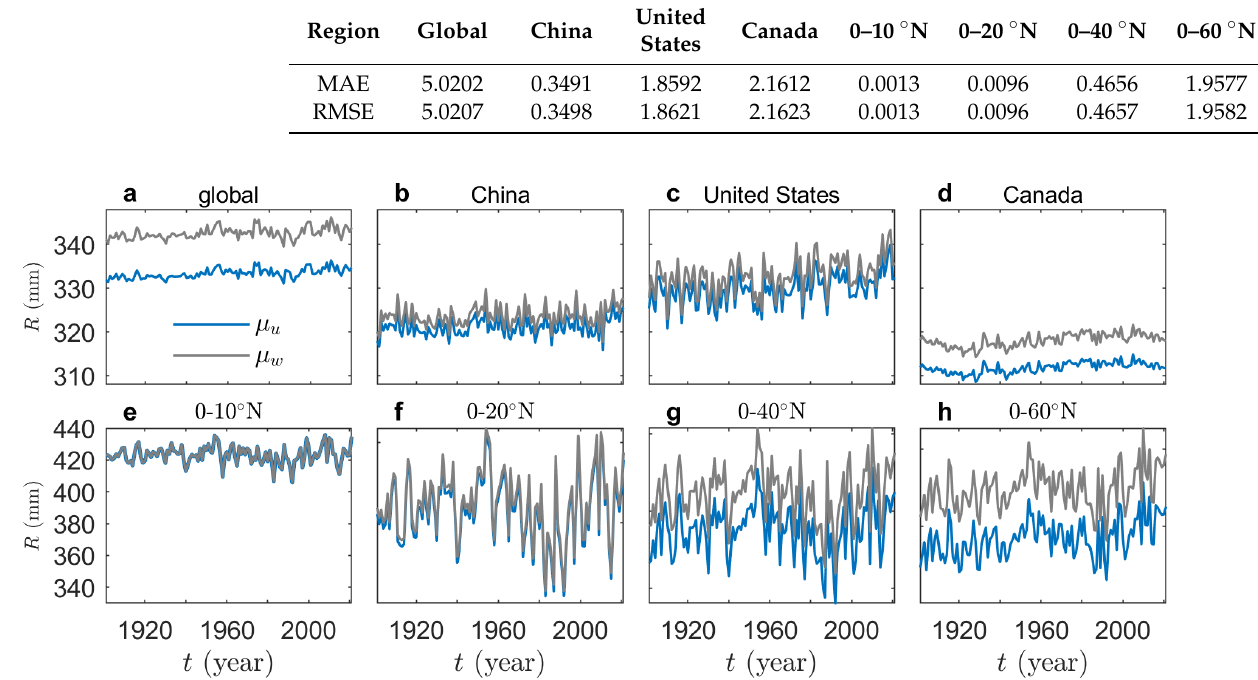
Table 1. MAE and RMSE among the weighted and unweighted temperature time series in 1901–2021 using CRU data.